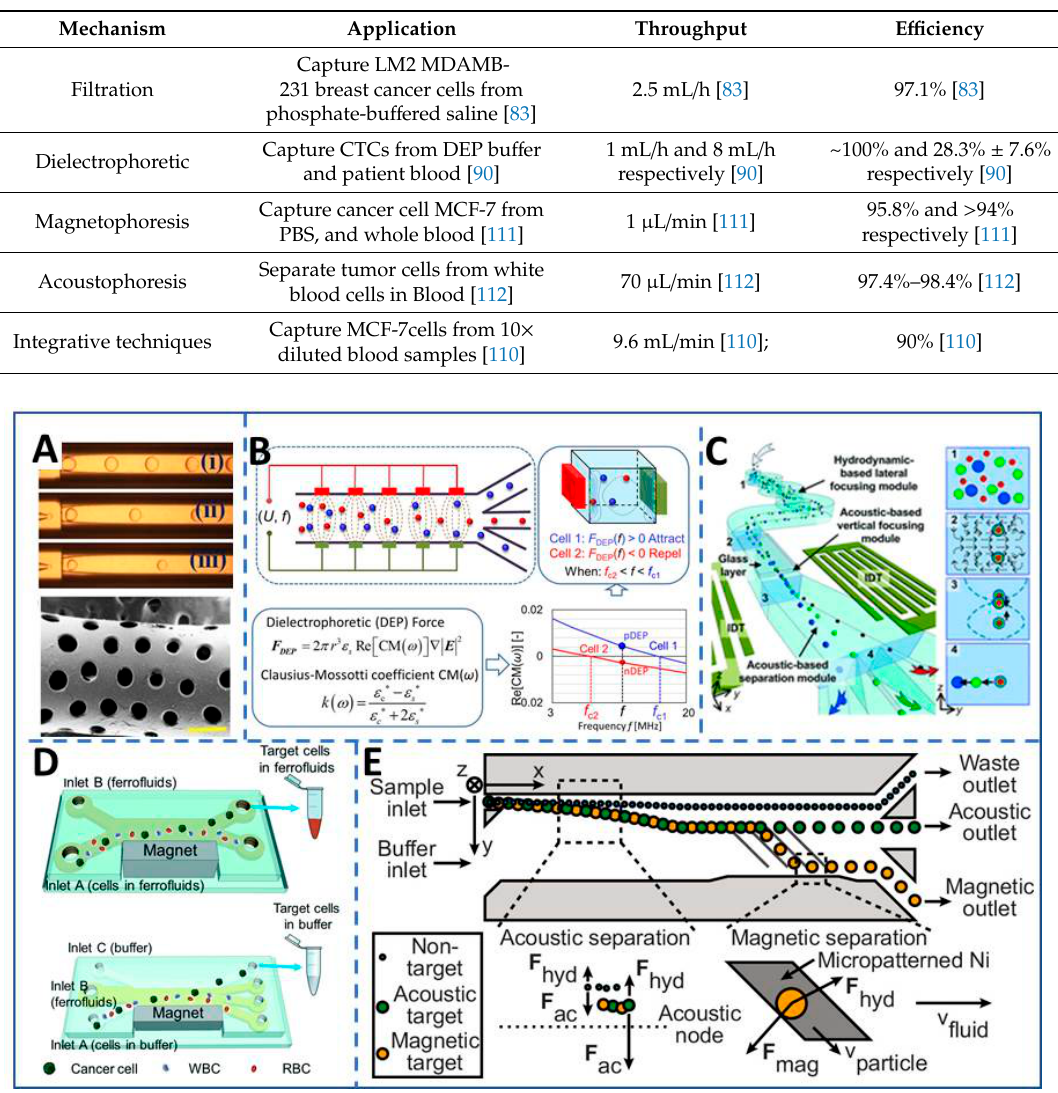
Figure 4. The application and mechanism of the microfluidic system without matrix for biomedical sorting with high throughput. ( A ) The filtering effect of porous scaffolds was used to dosing for the prevention of intrauterine adhesion, reproduced with permission from [78]. ( B ) Electrodes were embedded in a microfluidic device to manipulate cells by dielectrophoresis, reproduced with permission from [88]. ( C ) Acoustofluidic tweezers were used to focus and separate microparticles and cells into multiple high-purity fractions, reproduced with permission from [108]. ( D ) Magnetophoresis was used to separate cancer cells from blood cells in ferrofluids, reproduced with permission from [92]. ( E ) A microfluidic device integrated acoustics and magnetics to separate particles by multiple parameters, reproduced with permission from [109].